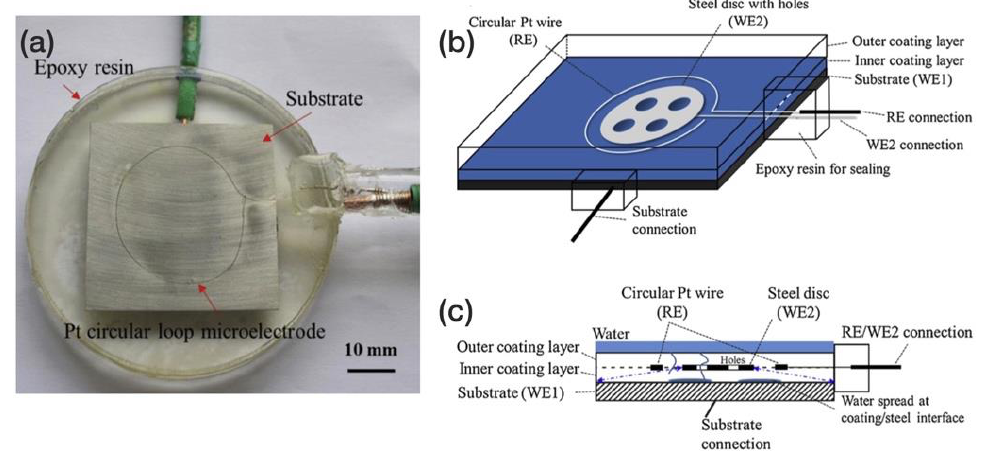
Figure 14. ( a ) A digital image of an EE montage for ENM measurement with an embedded Pt microelectrode at the metal–resin interface. ( b ) The schematics of the same montage, ( c ) Cut of the same set-up. Reprinted with permission from ref. [69]. Elsevier, 2019.